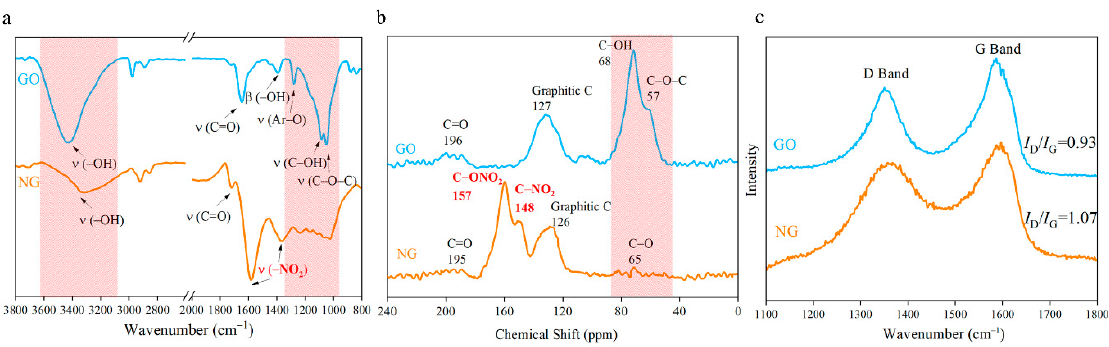
Figure 5. ( a ) Fourier transform infrared spectrometer (FTIR) spectra of NGO and GO; ( b ) 13C nuclear magnetic resonance spectroscopy (NMR) spectrum of NGO and GO; ( c ) Raman spectra of NGO and GO.